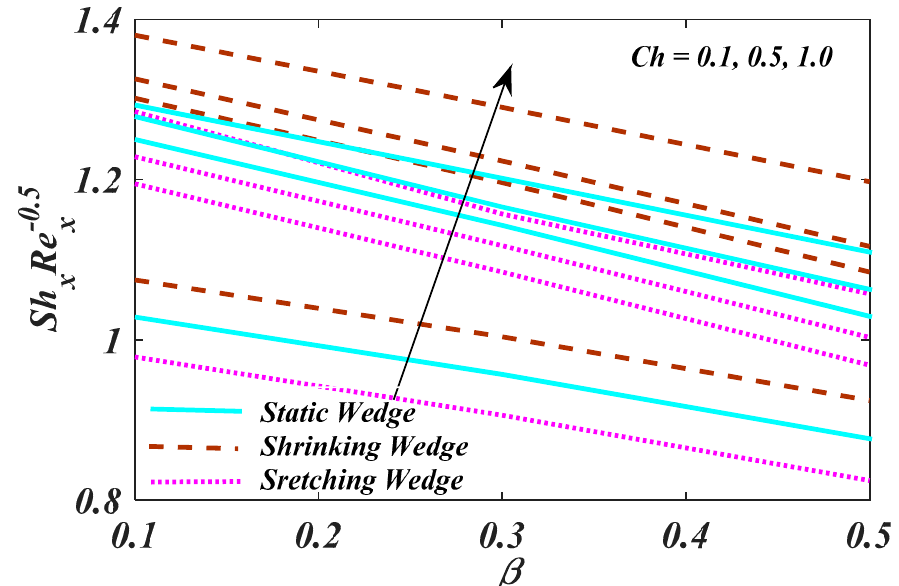
− 1/2 Figure 13. Plot of (cid:1844)(cid:1857) (cid:3051)(cid:2879)(cid:2869)/(cid:2870) (cid:1840)(cid:1873) with variations in (cid:2010) and (cid:1844)(cid:1856) . Figure 13. Plot of Re x Nu with variations in β and Rd .